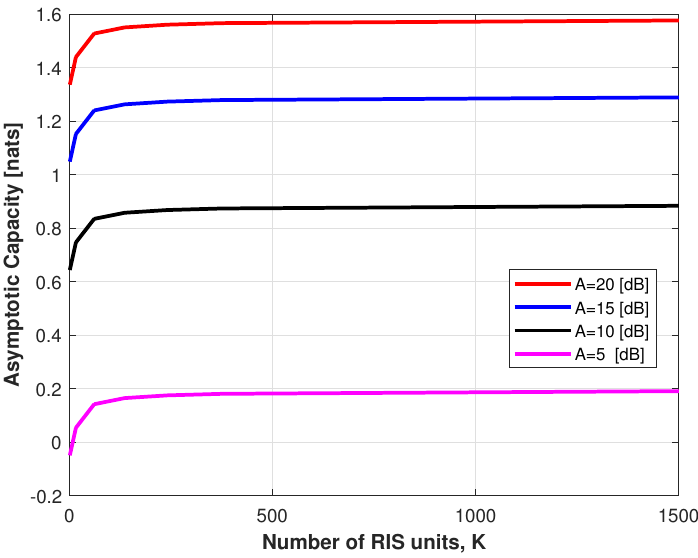
Figure 4. Asymptotic capacity of MISO-VLC channel in High-SNR scenario versus number of mirrors with different